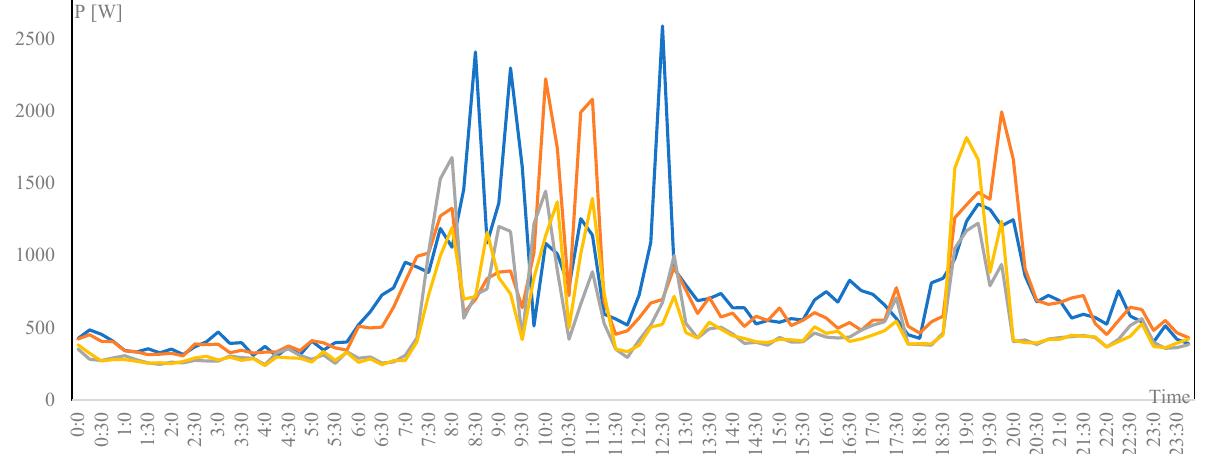
Figure 20. Load power profile for the different AEUs: AEU1 (blue), AEU2 (orange), AEU3 (grey), AEU4 (yellow).